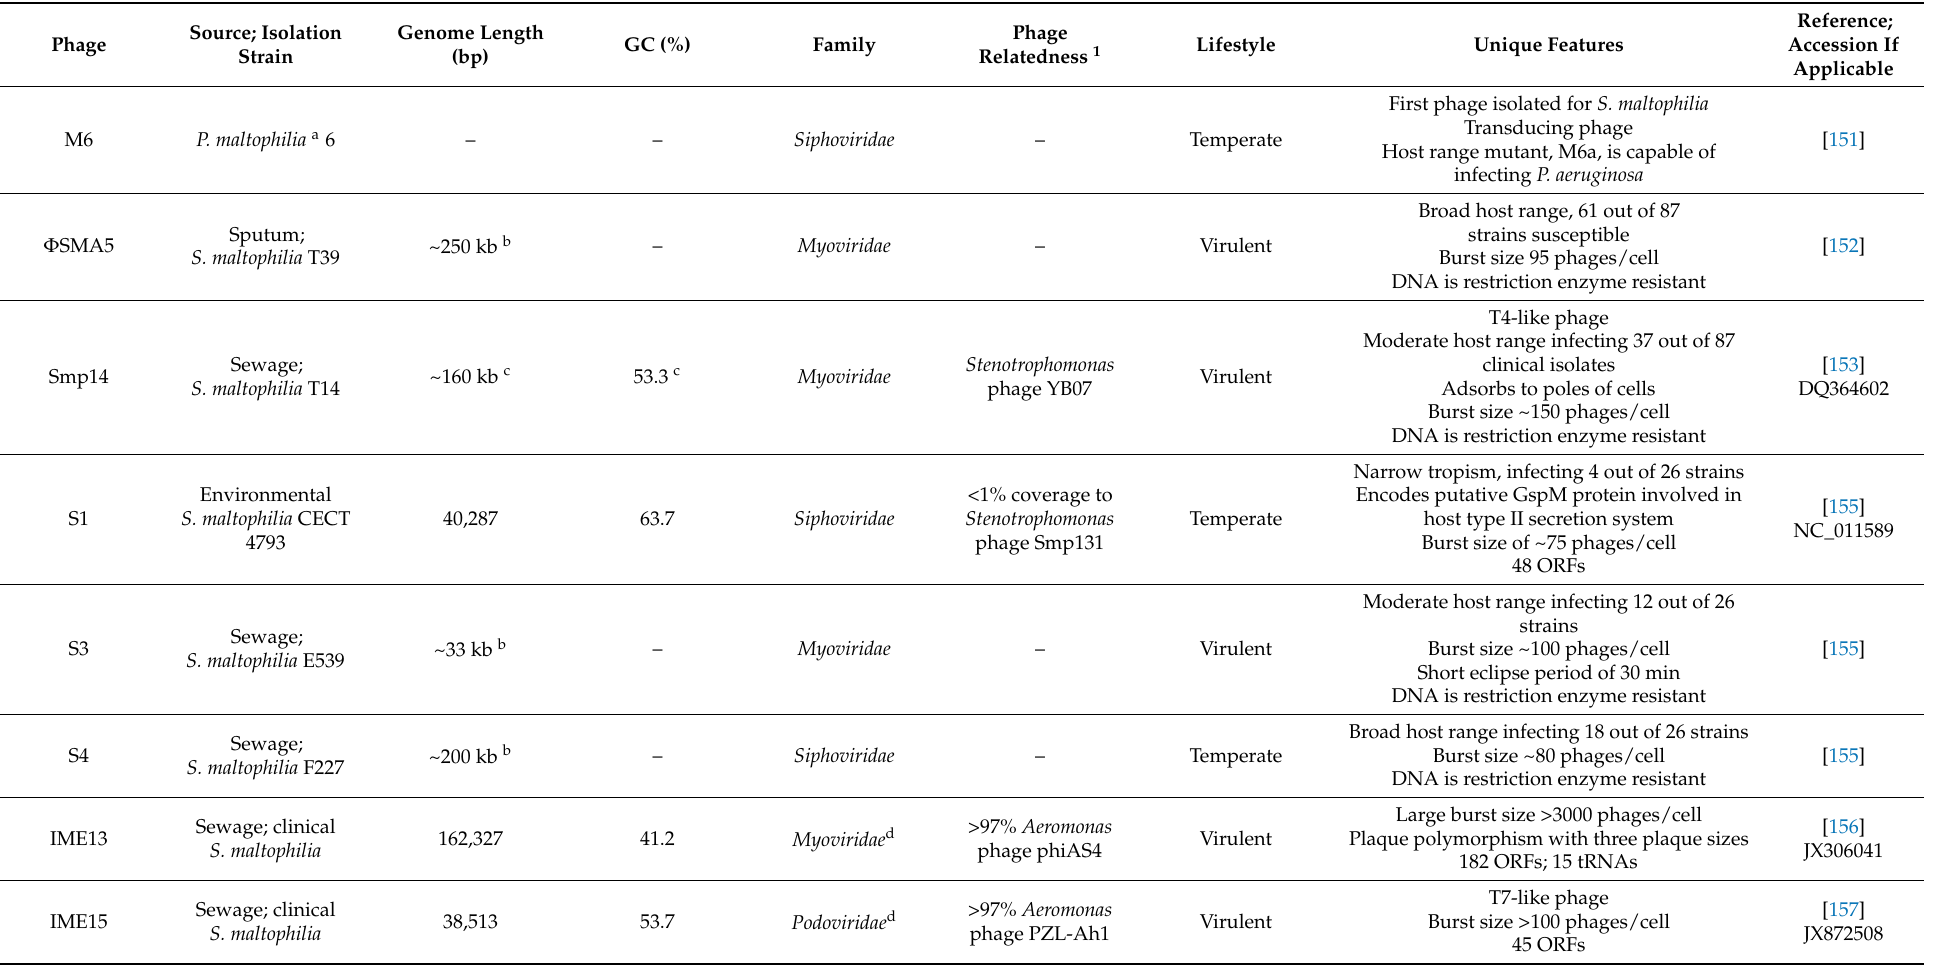
Table 1. S. maltophilia phage